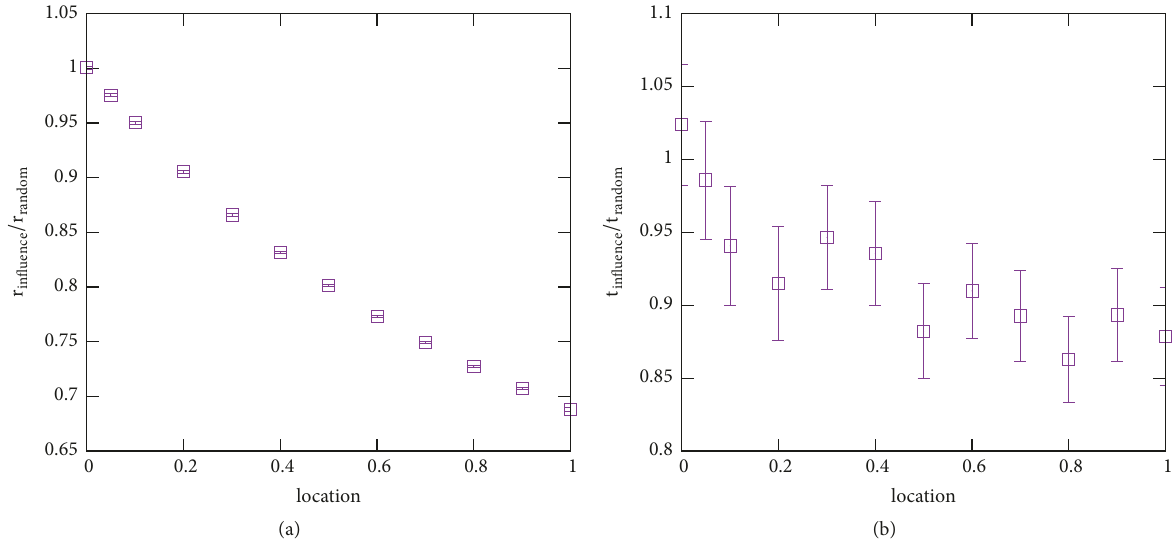
Figure 9: Dependence of the relative opinion spread 푟 influence /푟 random and relative relaxation times 푡 influence /푡 random on the distance of the location of the external influencers from 푥 = 0 . Locations at 푥 = 0 correspond to two external influencers holding identical opinions at 0 , whereas location 푥 = 1 corresponds to the two external influencers holding opinions ±1 . Results are averaged over 50 independent runs for a system of 푁 = 1000 nodes, 훿 = 1.5 , noise Δ = 0.001 , and ⟨푘⟩ = 10 .